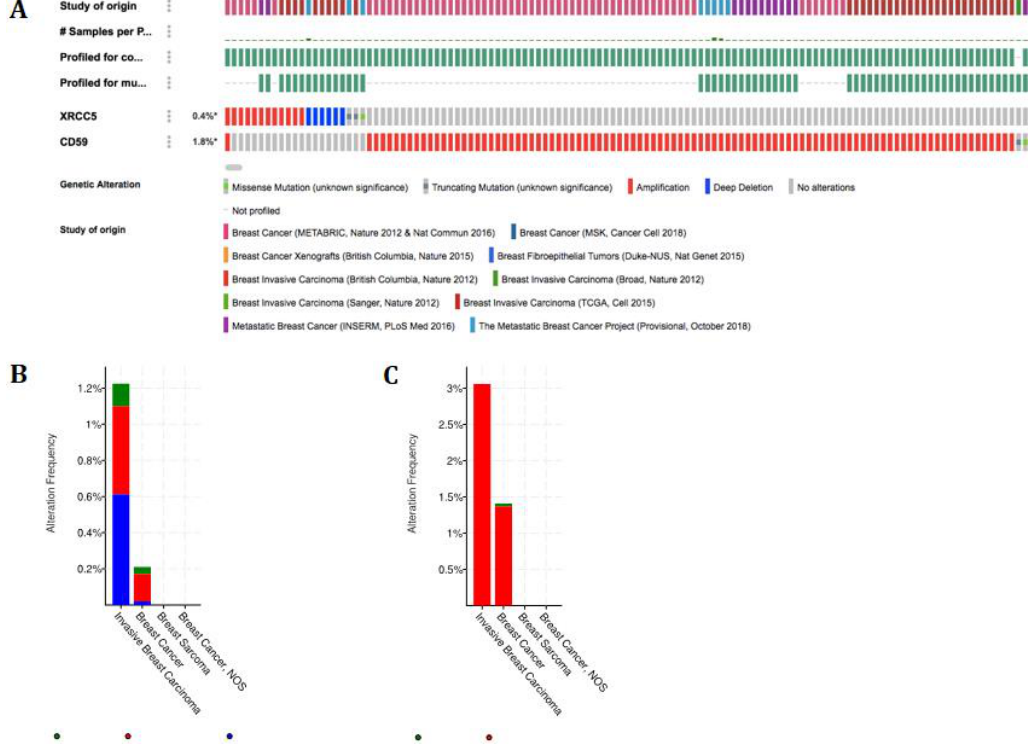
Figure 3. (A) Summary of gene alterations across different breast cancer samples. Summary of genetic alterations in (B) XRCC5 and (C) CD59 among different types of breast cancer, as analyzed by cBioPortal.